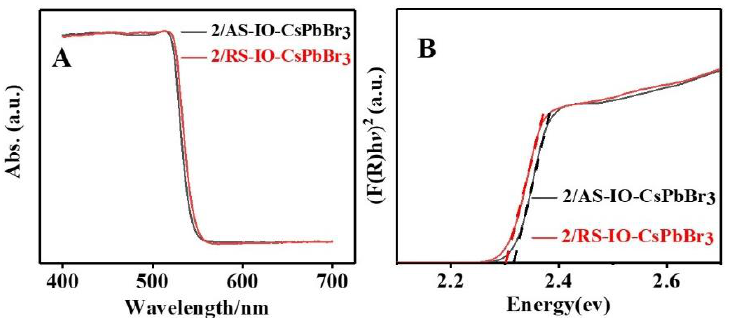
Figure 5. Normalized absorbance UV/Vis spectra ( A ) and Tauc plots ( B ) of 2/AS-IO-CsPbBr 3 and 2/RS-IO-CsPbBr 3